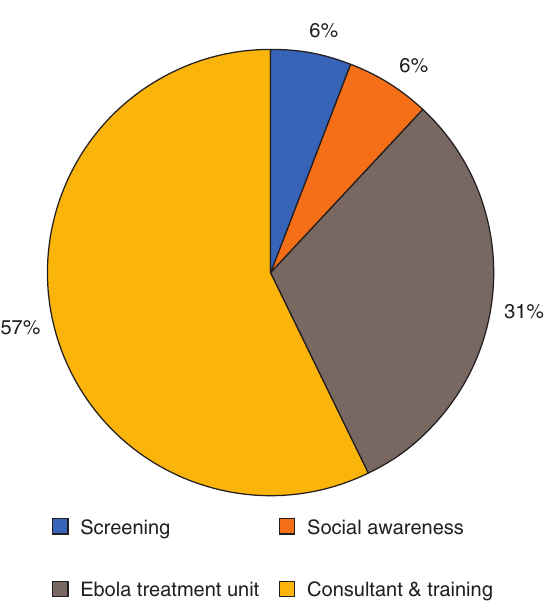
Percentage distribution of costs related to preventive actions adopted on site and adjacent